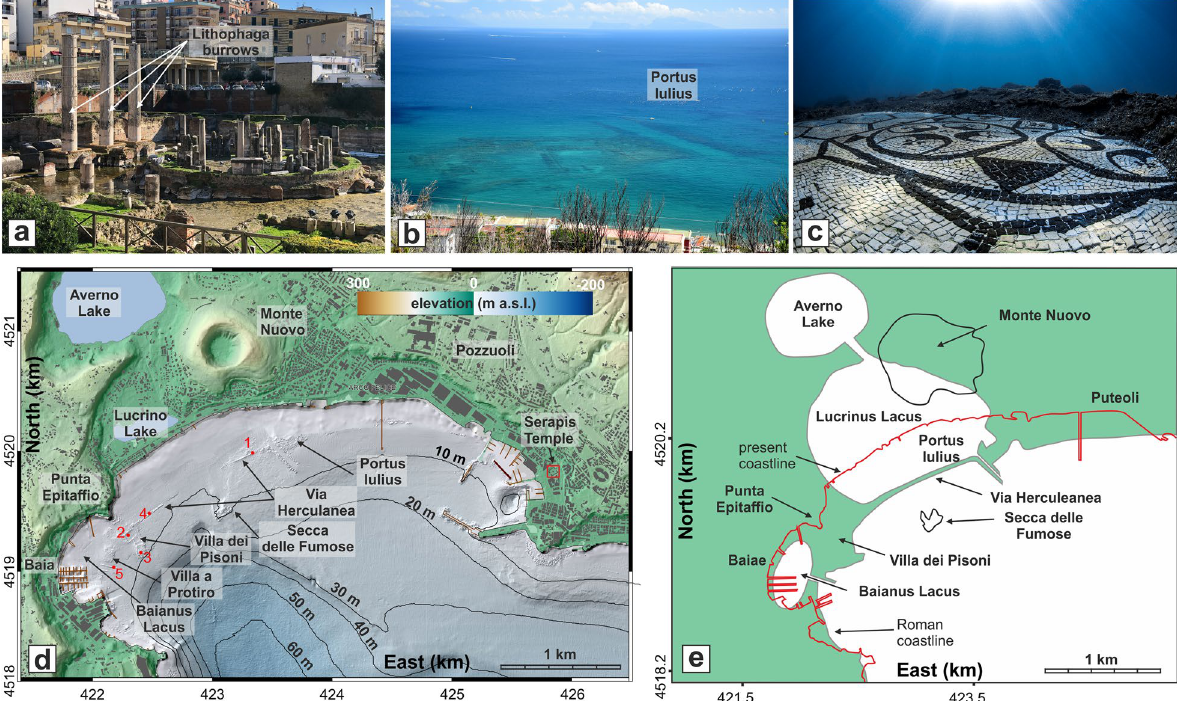
Fig. 2 a The Serapis Temple picture shows the Lithophaga mollusc burrows along the marble columns and the marble floor (photo by the authors). b Panoramic view of the submerged harbour structures of Portus Iulius as seen from Monte Nuovo (photo by the authors). c Submerged mosaic of Villa a Protiro (courtesy of Edoardo Ruspantini and Parco Archeologico dei Campi Flegrei). d The map shows the presently submerged Portus Iulius and Baianus Lacus areas (modified after Somma et al. 2016). Locations of archaeological data (red dots) used for the topographic restoration are also reported (data from Passaro et al. 2013). e Morphological reconstruction of the Portus Iulius and Roman coast (modified after Passaro et al. 2013;